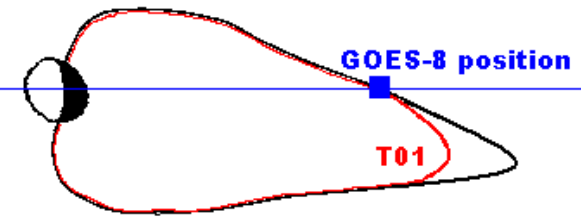
Fig. 5. Sketch of a T01 magnetic field line (red line) which is not stretched enough and has a too large radius of curvature value at the apex, while the magnetic elevation angle at the GOES-8 position (blue square) is close to the actual configuration (black